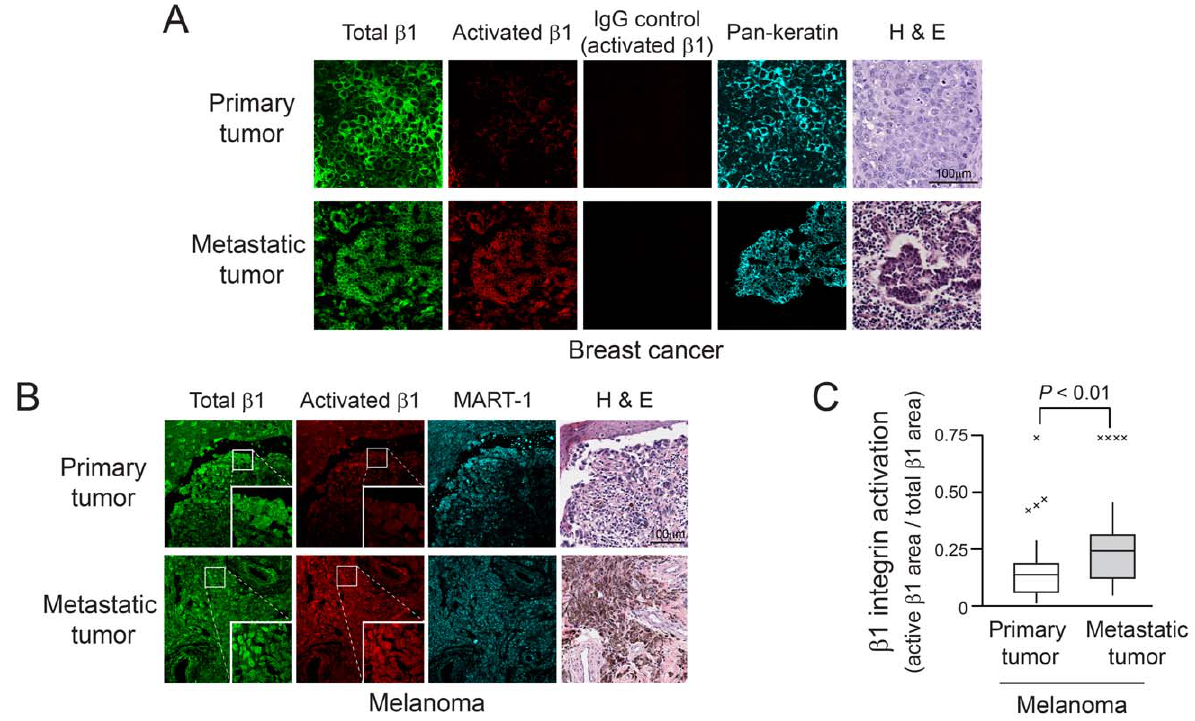
Figure 6. Activated b 1 integrins in primary and metastatic human tumors. (A and B) Representative immunostaining of FFPE tissue sections for total b 1 integrin (antibody 4B7R) and activated b 1 integrin (antibody 9EG7) in primary and metastatic tumors. For detection and analysis of tumor cells, samples were stained with an antibody to pan-keratin (breast cancer) (A) or MART-1 (melanoma) (B). The breast cancer metastasis was from a lymph node and the melanoma metastasis was from the abdominal cavity. Primary and metastatic tumors were from different patients. Note that in the primary breast tumor and metastatic melanoma, activated b 1 integrins were observed in some connective tissue cells as well as in tumor cells. Fluorescence images of primary and metastatic tumors were processed identically. (C) Box plot showing b 1 integrin activation in primary (n=50) and metastatic (n=26) melanomas in a tissue microarray. The proportion of areas with activated b 1 integrin to total b 1 integrin within MART-1 positive melanoma cells was analyzed with Volocity software. Statistical analysis was performed by Mann-Whitney U test (Outliers, values outside of 1.5 X interquartile distance from the quartiles, are indicated by an X).